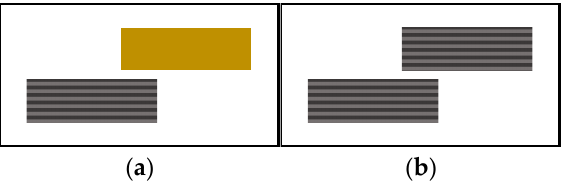
Figure 3. Single-lap welded joints for IW ( a ) welding of PEI on CF/PEEK and ( b ) welding of CF/PEEK on CF/PEEK (yellow bar is PEI, grey bars for CF/PEEK)